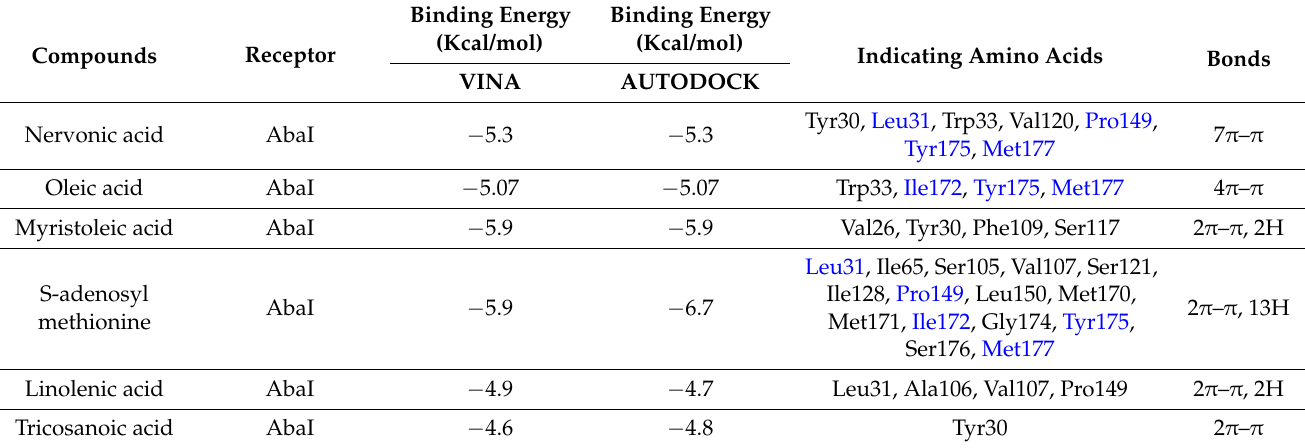
Figure 4. Interactions of ligands with AbaI receptor protein with nervonic ( A ), oleic ( B ), and myristoleic acid ( C ). Table 1. Binding energies of targeted ligands with AbaI. Amino acid residues essentially required for binding are colored blue.